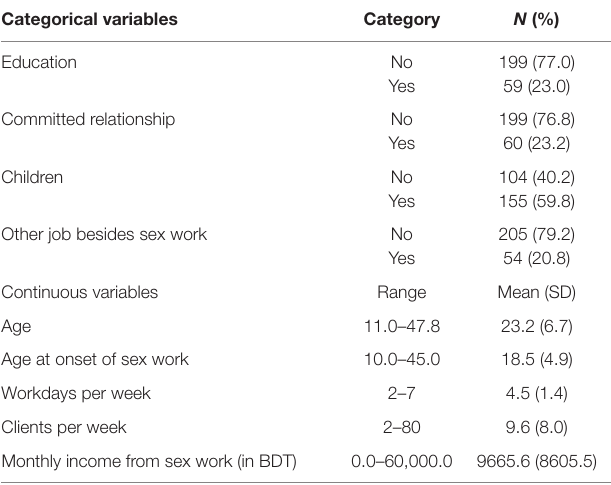
TaBle 1 | characteristics of study